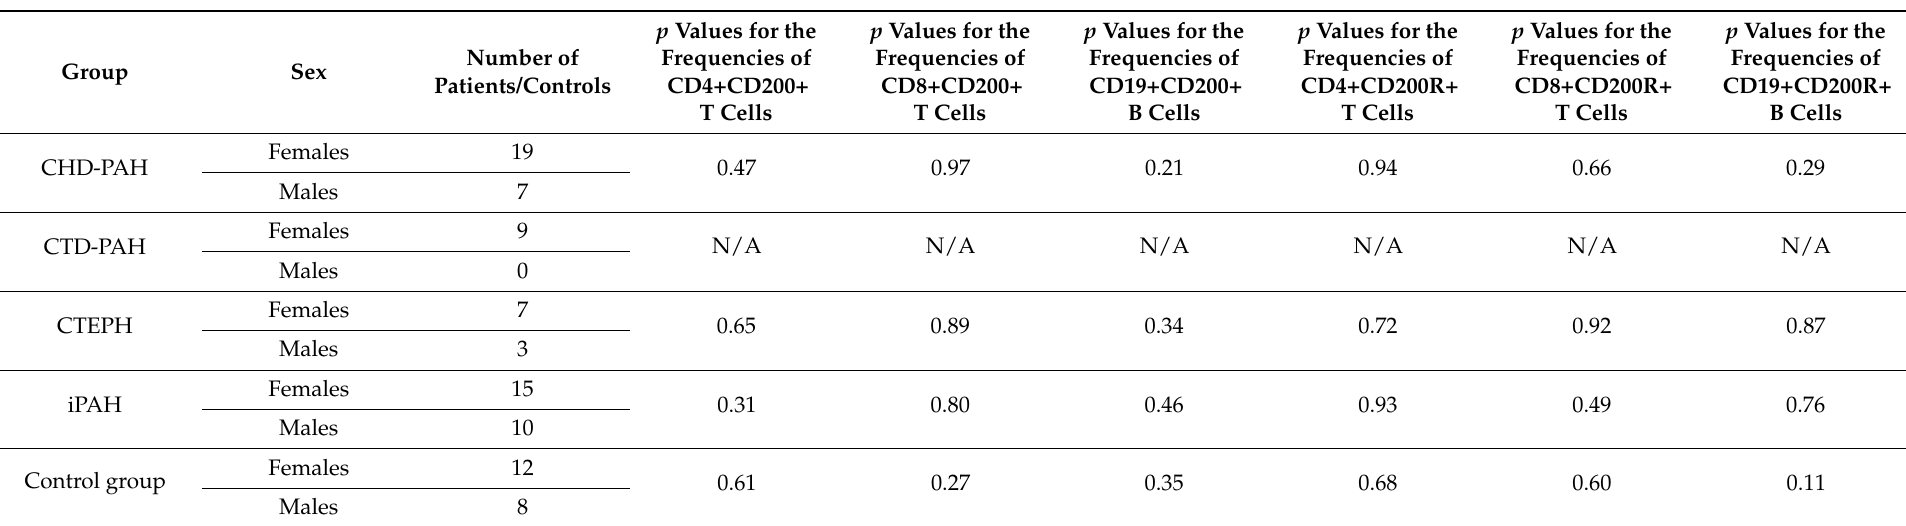
Table 1. The sex of patients with selected types of pulmonary arterial hypertension (PAH) and persons from the control group.